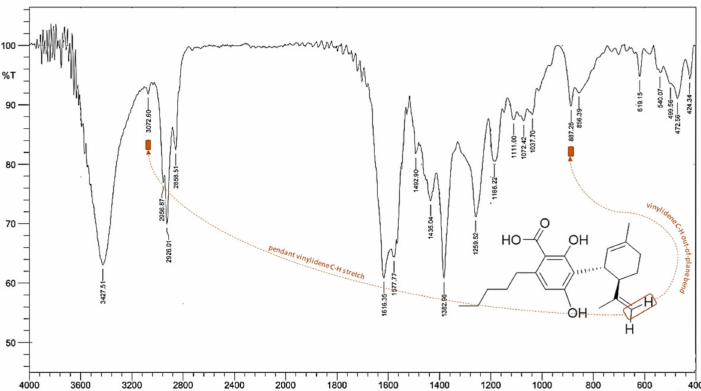
Figure 10. Fourier transform infrared spectroscopy (FT-IR) spectrum of CBDA, which was recorded in the region of 400–4000 cm –1 using the Prestige 21 system (Shimadzu, Japan), equipped with a DTGS KBr (tridiglycinsulfatedeuterate with KBr window; 8000–400 cm − 1 ) detector, with a 4 cm − 1 (45 scans) resolution. The disc having a diameter of 13 mm, a thickness of 2 mm, weight of 200 mg, and containing 1% by weight of sample in KBr, was obtained by pressing the sample powder in a cylindrical support using a manual Specac press. The spectral analysis was carried out using the Prestige software (IR